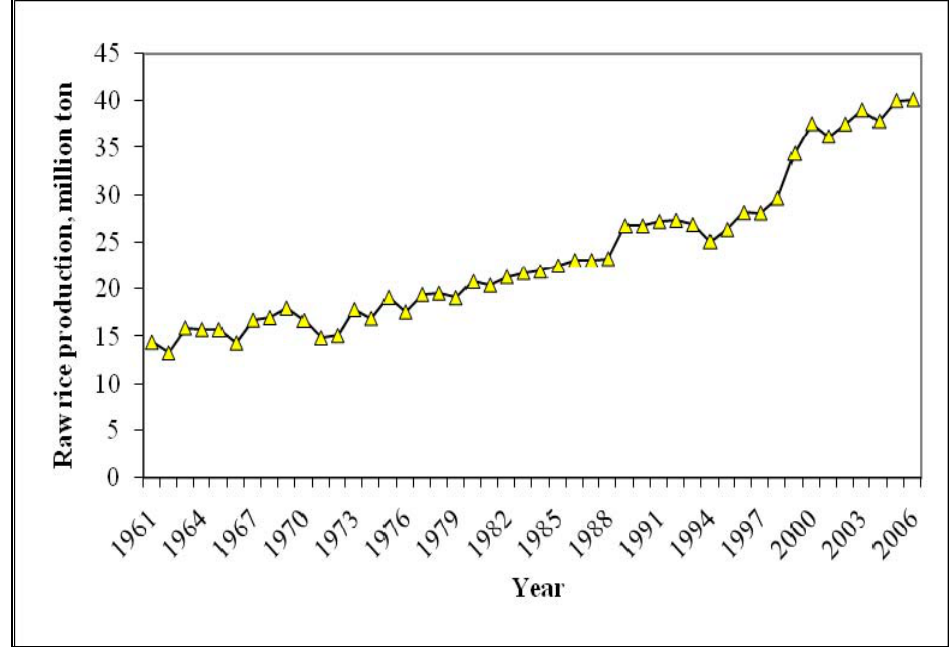
Figure 1 . Production of raw rice (paddy) in Bangladesh [3].